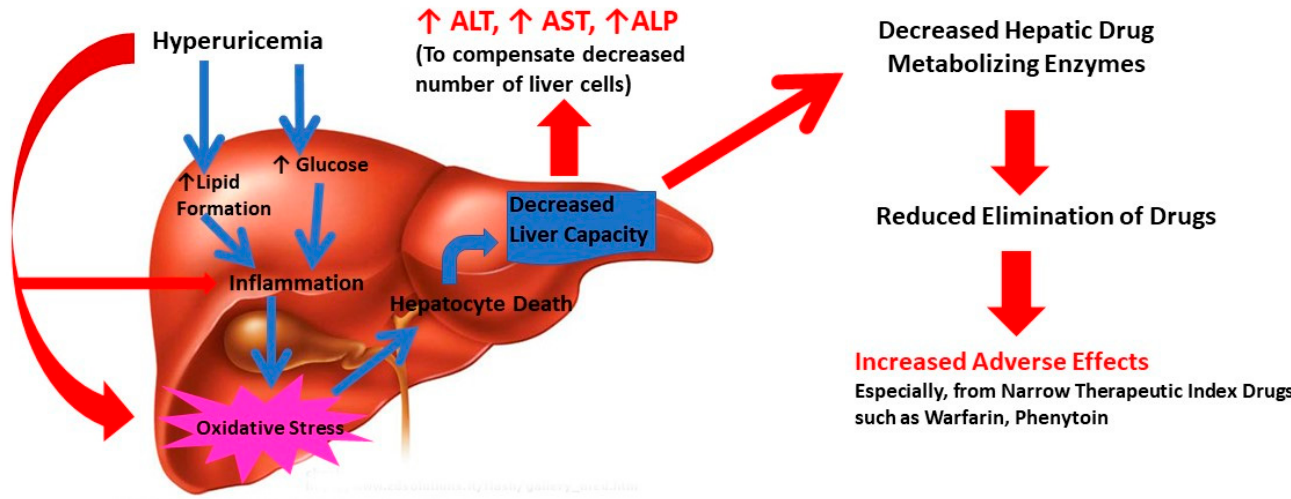
Figure 1. Potential pathophysiological mechanism of hyperuricemia related liver dysfunction in gout.